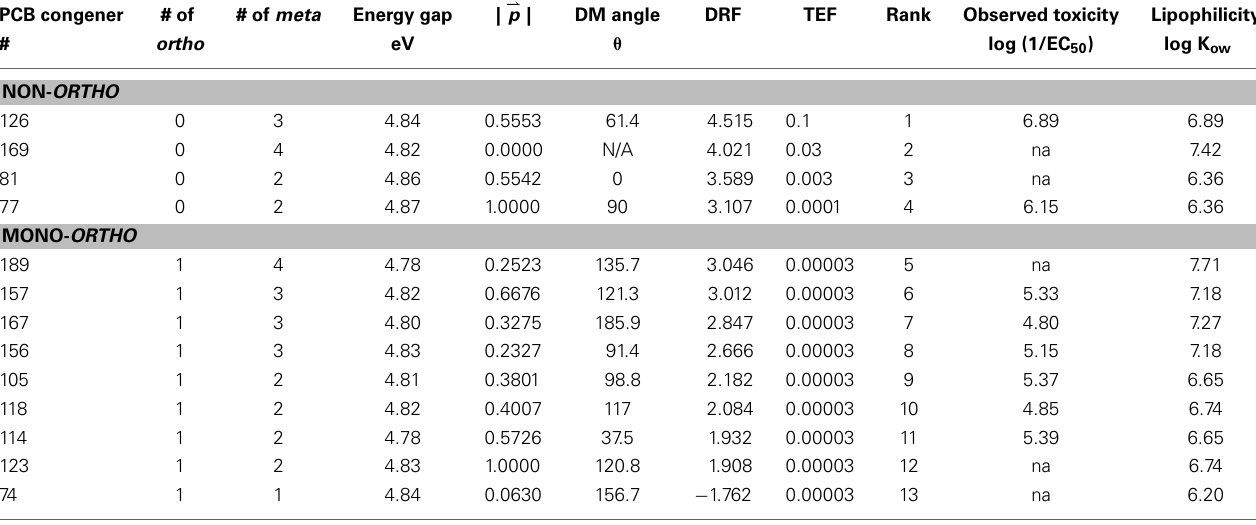
Table 1 | Structural and electronic configuration parameters of the dioxin-like PCBs and the toxicity ranking predicted by first principles model. PCB